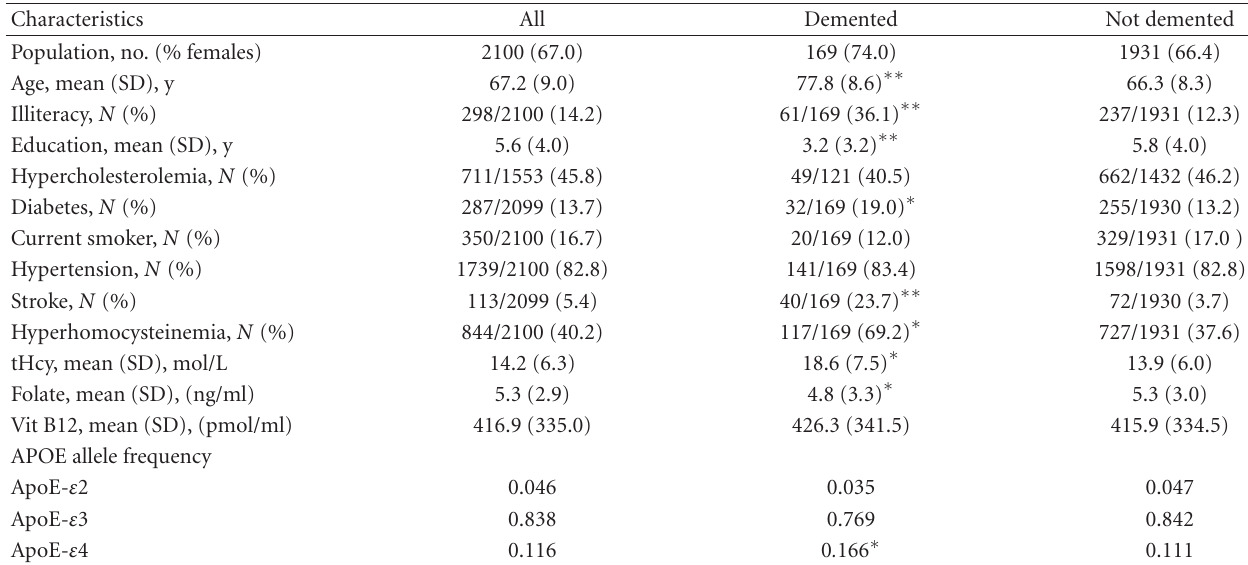
Table 1: Characteristics of the Maracaibo Aging Study